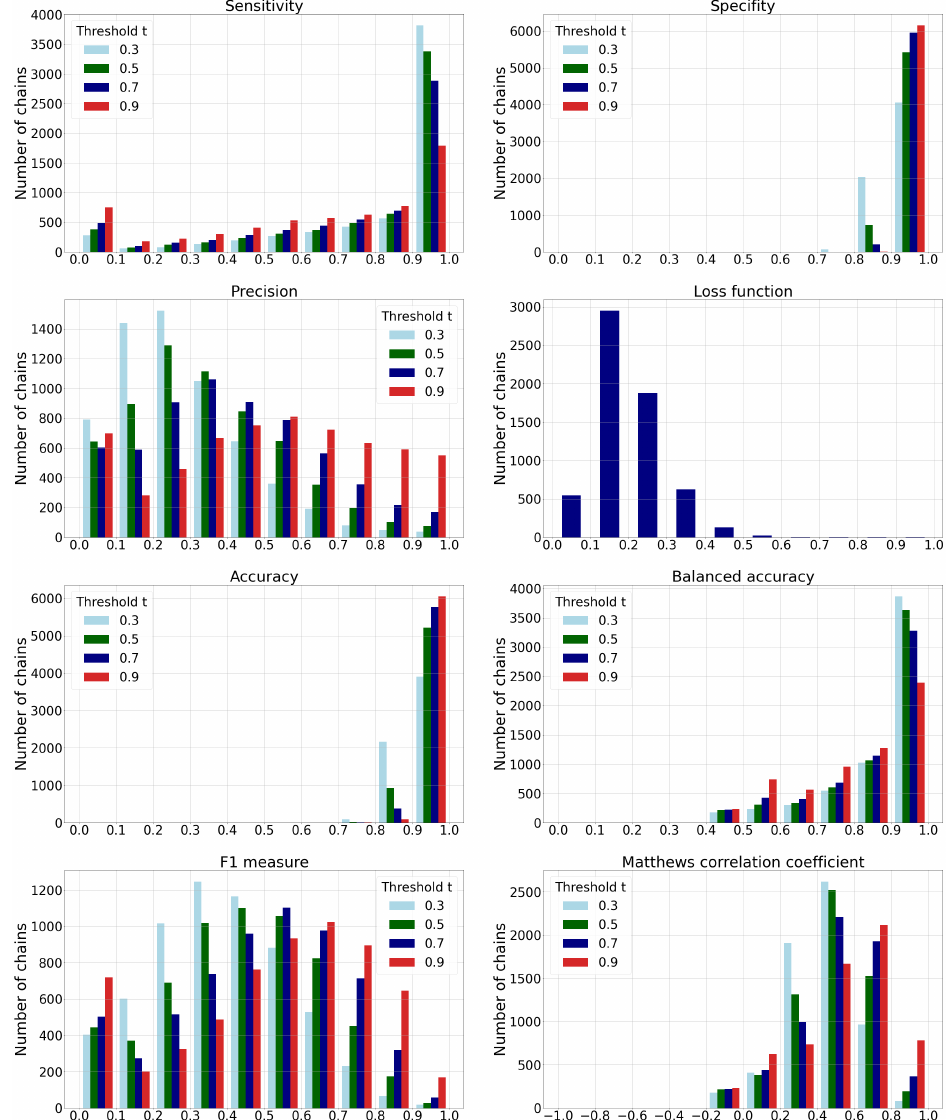
Figure 10. Histograms of different performance metric values. For all metrics except for the loss function, the histograms are shown for different thresholds t ∈ [ 0.3,0.5,0.7,0.9 ] . The data contain joint results obtained on all ten test data